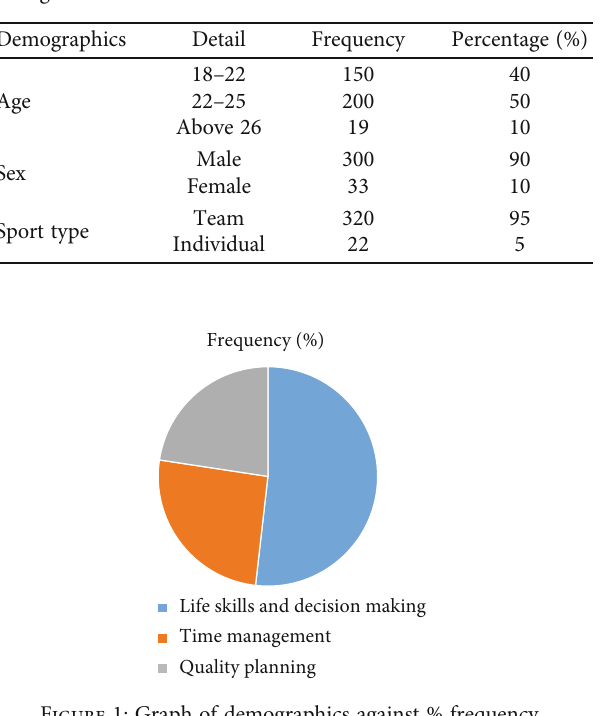
Table 1: De fi nition and e ff ects of peer, active, and lecturing strategies.